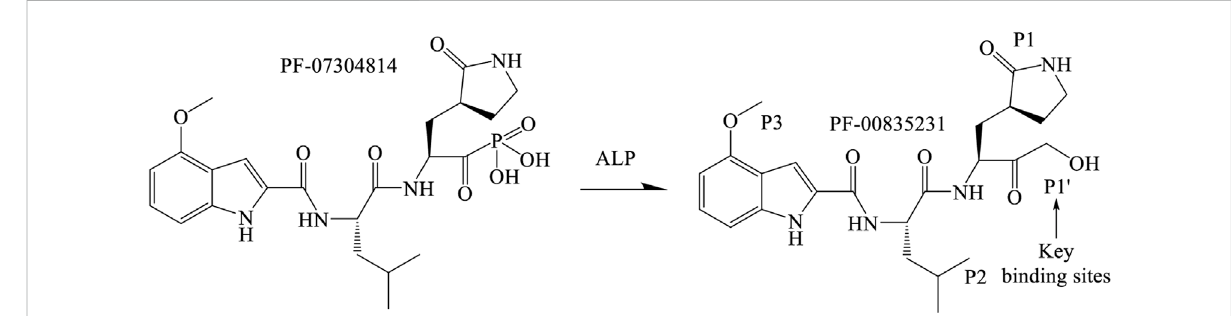
FIGURE 1 Mechanism and major binding site of PF-07304814 to suppress M pro